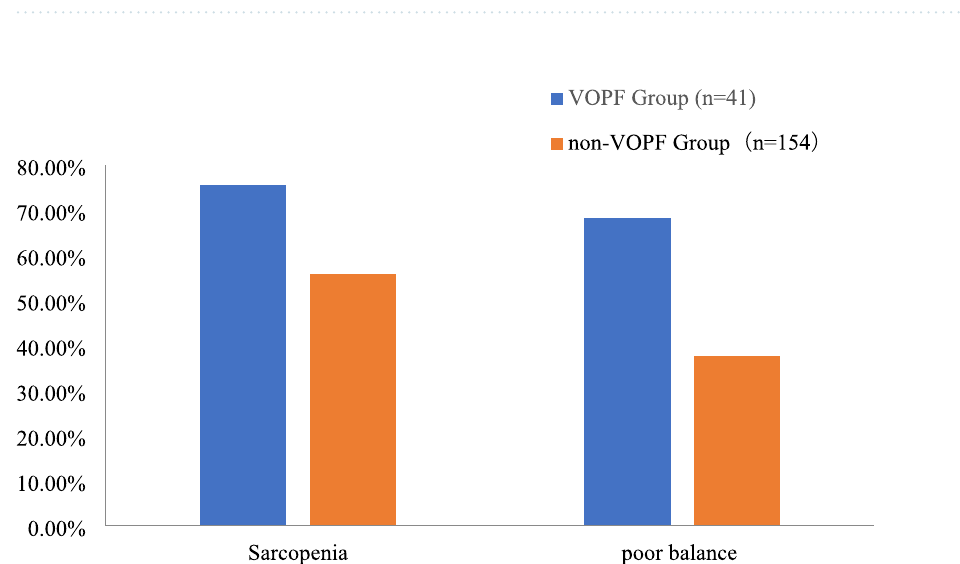
Figure 2. Comparison of sarcopenia and poor balance between female RA with VOPF or